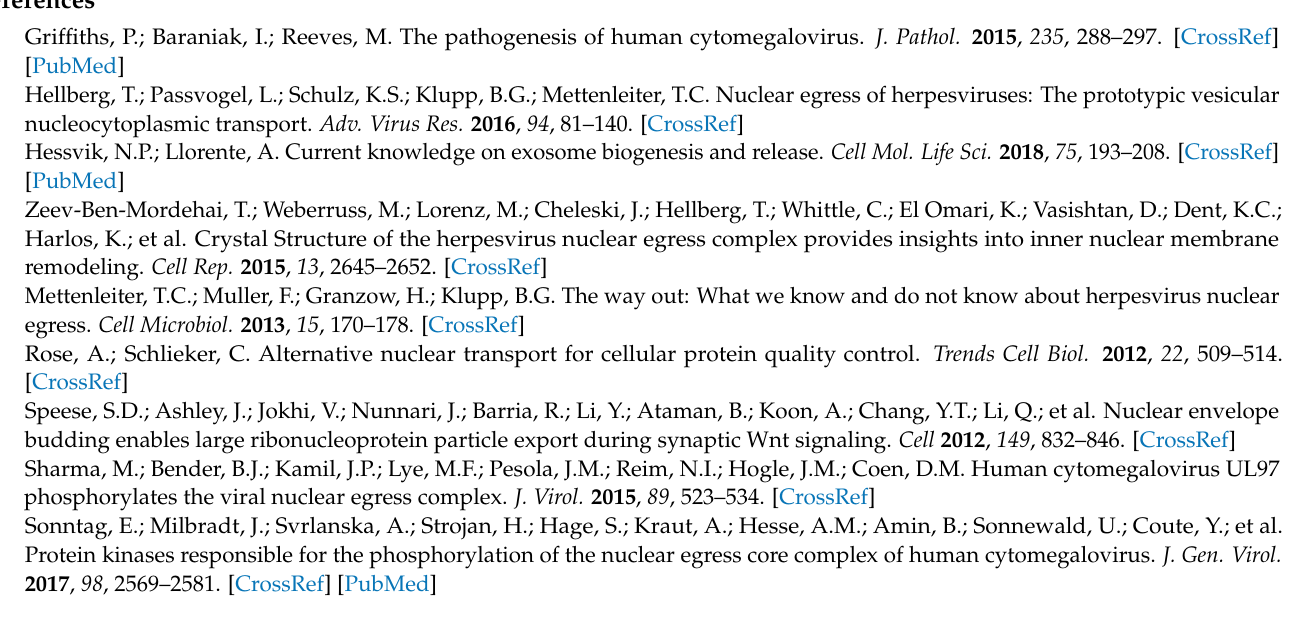
particles. Figure S2: Histograms illustrating the distribution and variance of the individual values of the measurements. Figure S3: Quantitative evaluation of IE1 expression in ∆ UL50C- and ∆ UL50N- infected HFF-UL50. Figure S4: Confocal IF detection of viral IE, E and L proteins in ∆ UL50C- and ∆ UL50N-infected HFF-UL50. Table S1: Differential proteomic analysis of NIEPS fractions enriched from pUL50-complementing cells ( ∆ UL50C) or non-complementing cells ( ∆ UL50N). Table S2: Quantitative proteomic analysis of virions purified from pUL50-complementing cells ( ∆